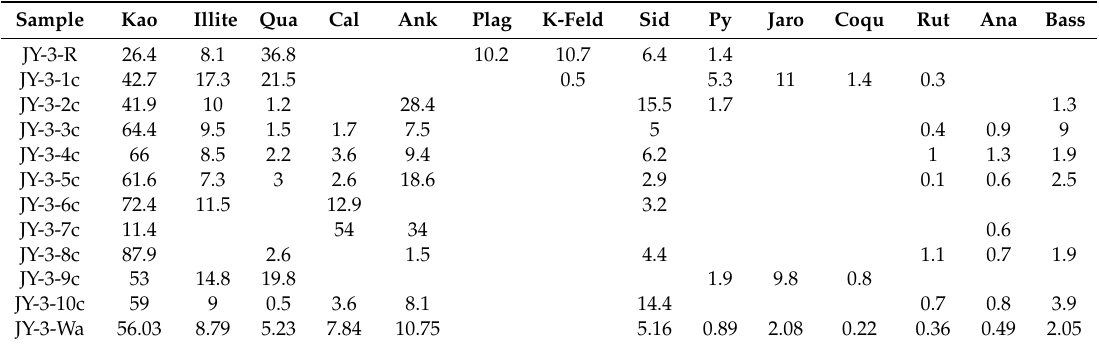
Table 2. Contents of minerals of the Jinyuan coal LTAs and roof samples measured by XRD and Siroquant